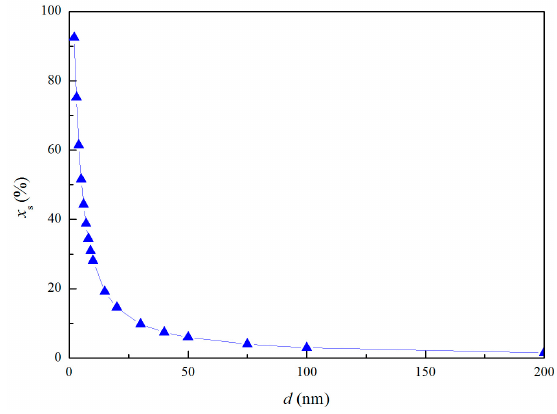
Figure 2. Relationship between the atomic fraction and the diameter of the MgO nano-particle.